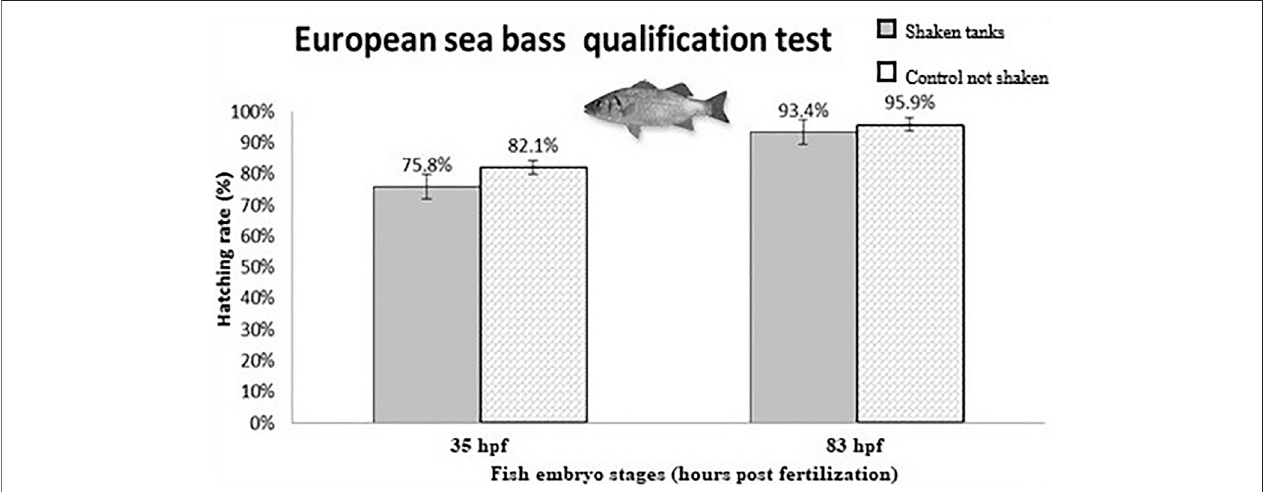
FIGURE 5 | European seabass embryo hatching rate following acoustic and mechanical vibrations from a simulated Soyuz launch quali fi cation test (from Przybyla et al.,